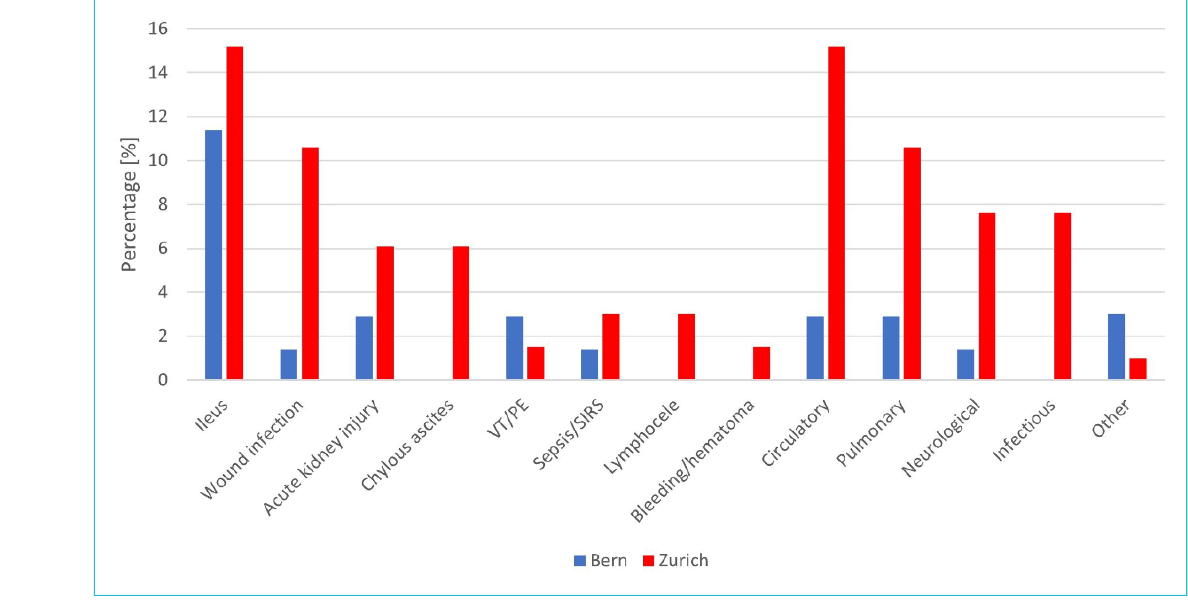
Figure 3: Postoperative complications after post-chemotherapy retroperitoneal lymph node dissection by centre (VT/PE: venous thromboem- bolism/pulmonary embolism; SIRS: systemic inflammatory response